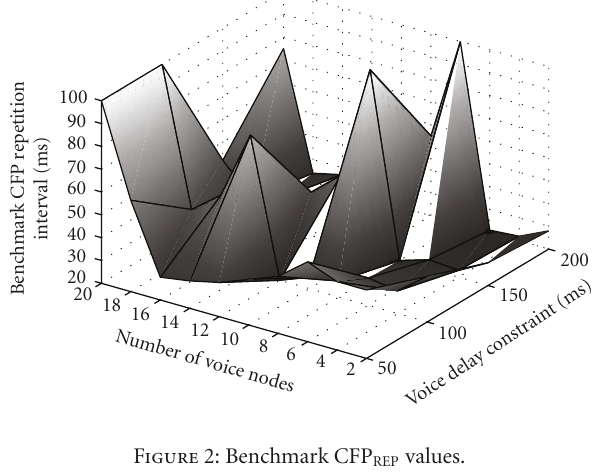
Figure 2: Benchmark CFP REP values.